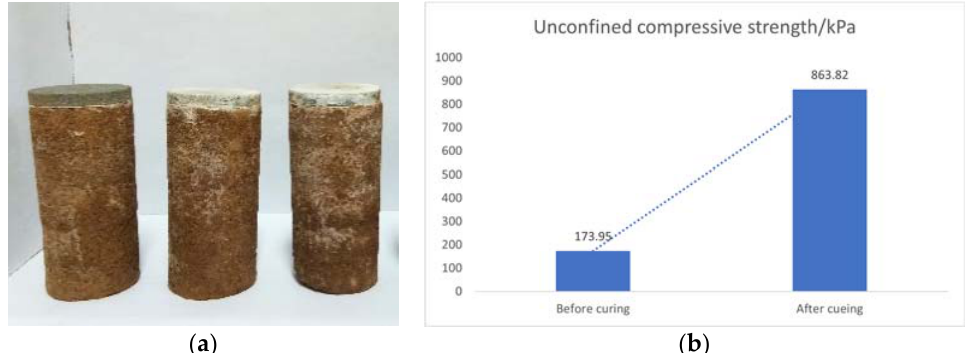
Figure 2. Change diagram of unconfined compressive strength of loess sample after MICP curing and after curing. ( a ) Loess sample cured by MICP; ( b ) Change diagram of unconfined compressive strength before and after MICP curing.